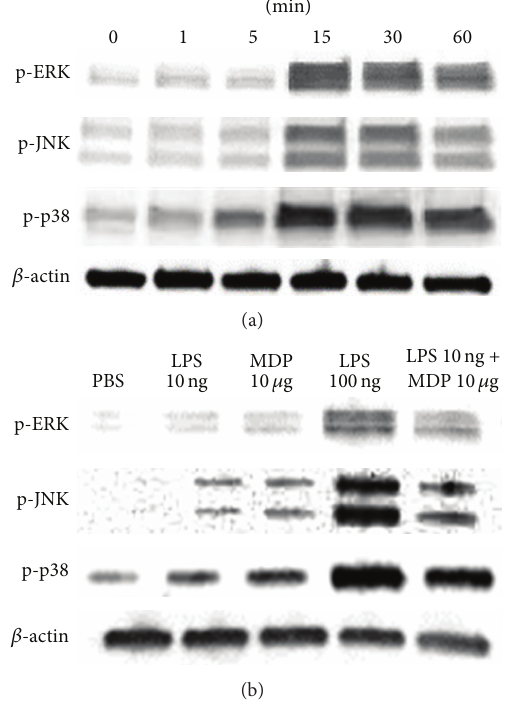
Figure 9: Effect of muramyl dipeptide (MDP) on lipopolysaccha- ride- (LPS-) induced mitogen-activated protein kinase (MAPK) signaling in mouse stromal cell in vitro . (a) Stromal cells were stimulatedusingLPS(100 ng/mL)asindicated.Cellswerethenlysed and analyzed by western blotting. (b) Stromal cells were stimulated using PBS, LPS (10ng/mL), MDP (10 𝜇 g/mL), LPS (100ng/mL), or LPS (10ng/mL) + MDP (10 𝜇 g/mL) for 15min. Cells were then lysed and analyzed by western